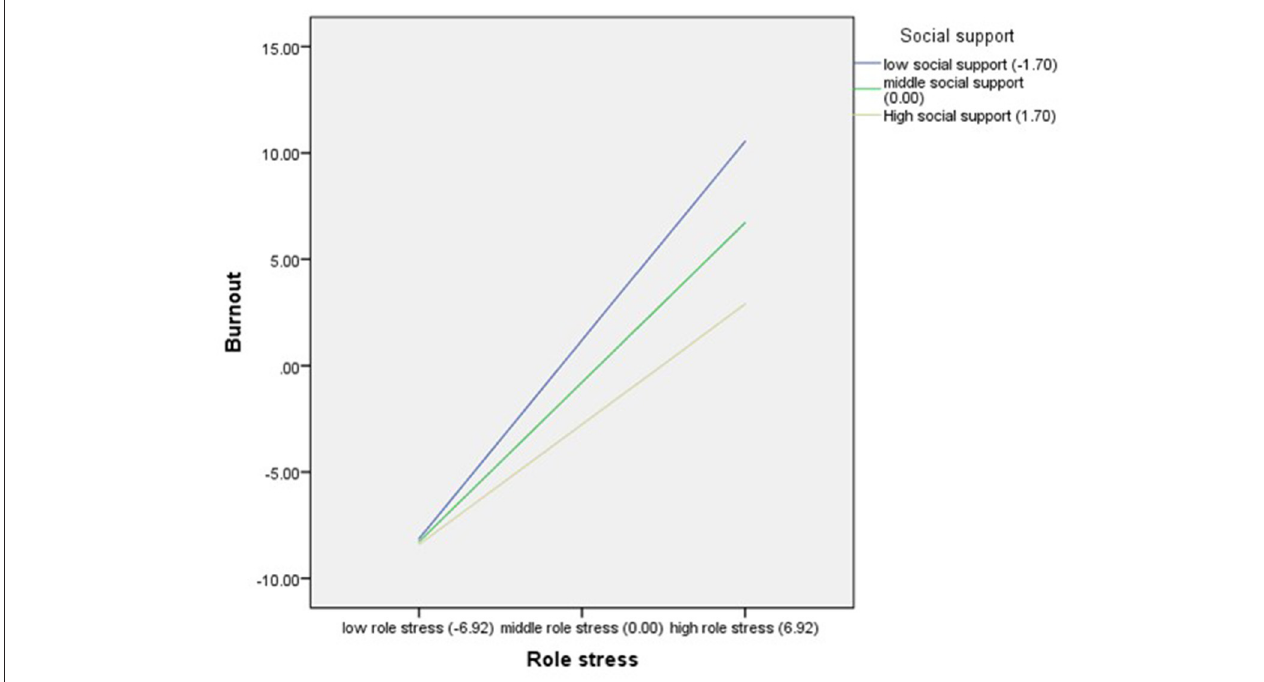
FIGURE 2 | Social support as a moderator between role stress and